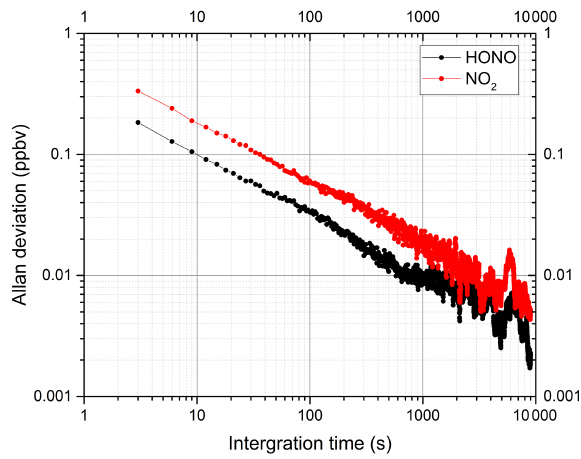
Figure 7. Allan deviation plots for the measurements of HONO and NO 2 . The Allan deviations of HONO and NO 2 are 0.08 and 0.14ppbv at an integration time of 60s respectively.